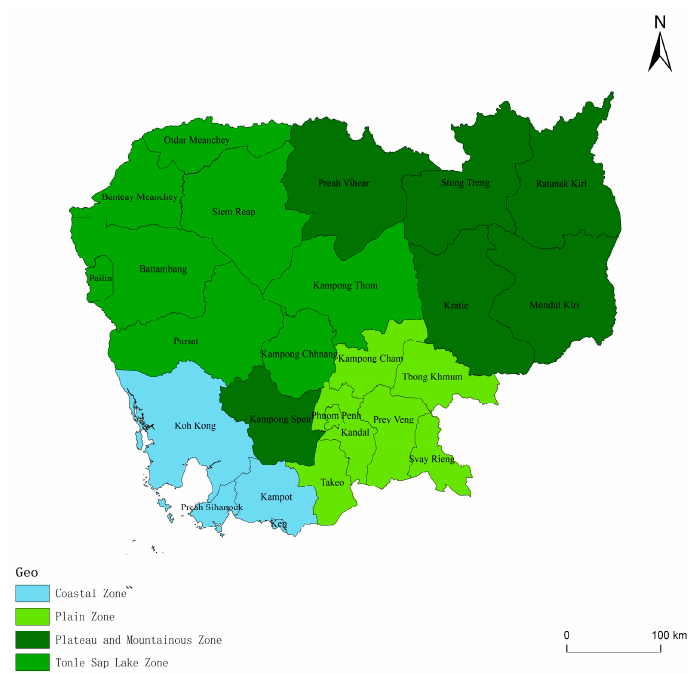
Figure 1. Geographical map of Cambodia.